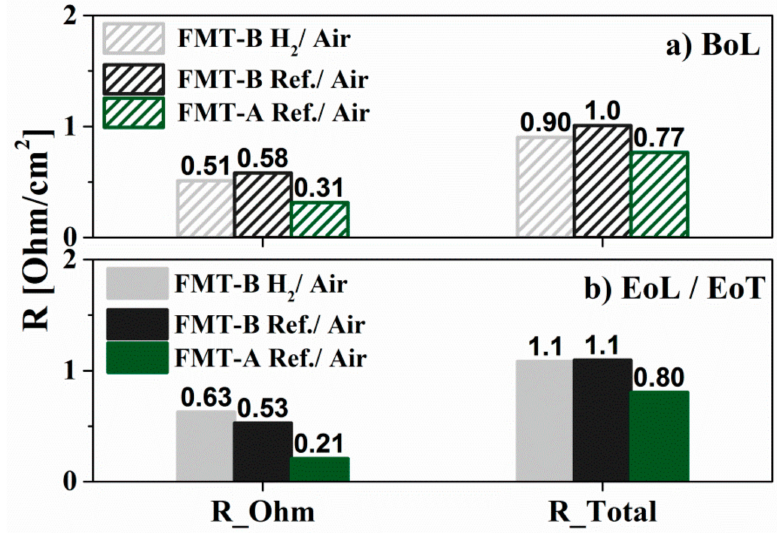
Figure 4. Ohmic resistance (R_Ohm), total resistance (R_Total), and the ratio of them (R_Ohm / Total) of FMT-A and FMT-B calculated from Figure 3.